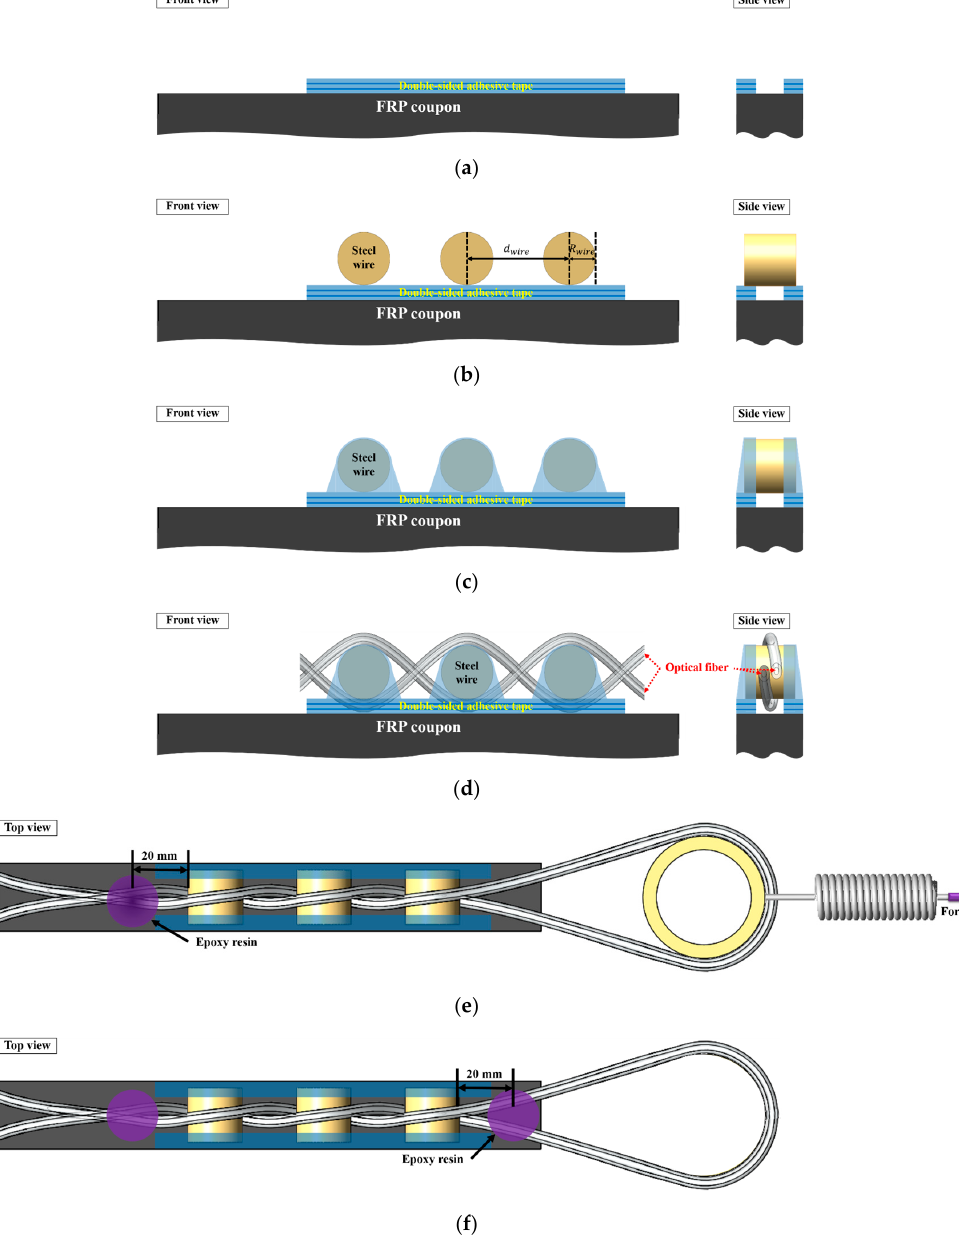
Figure 8. Intensity-based FOS head fabrication process.